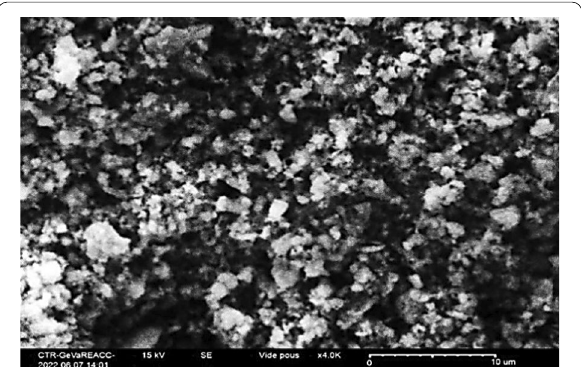
Fig. 2 SEM imaging of fluorapatite doped by cobalt